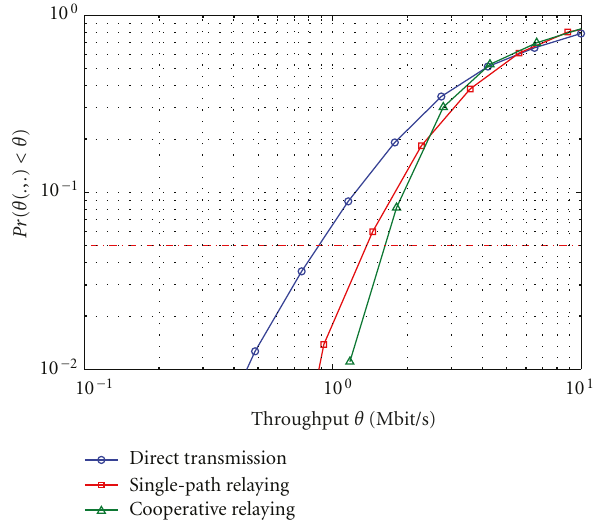
Figure 7: User throughput CDF for cooperative relaying in wide area scenario with 3 RSs per sector.